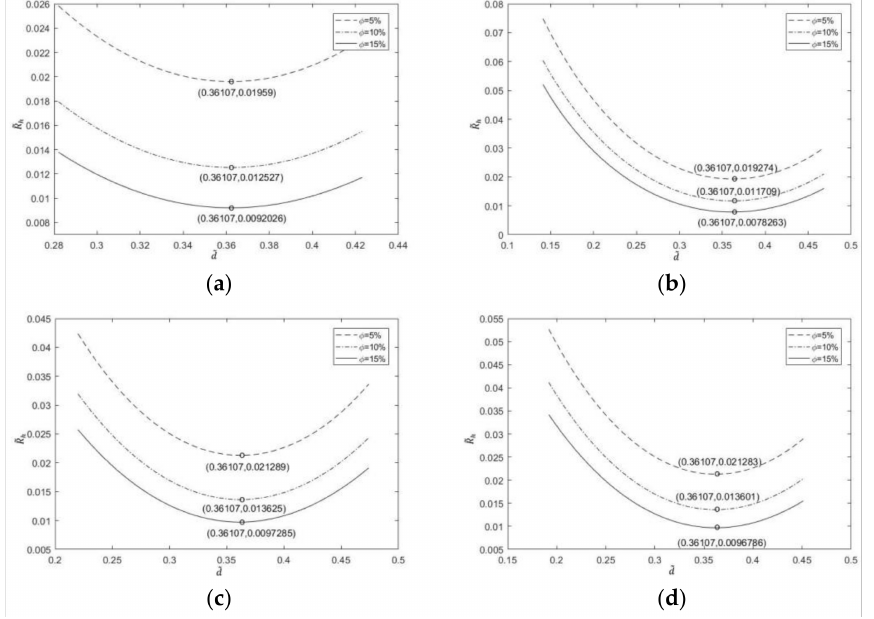
Figure 15. The influence of ϕ on (cid:101) R h in four models at N = 6. Where subfigures ( a – d ) are Model 1, 2, 3 and 4 respectively.